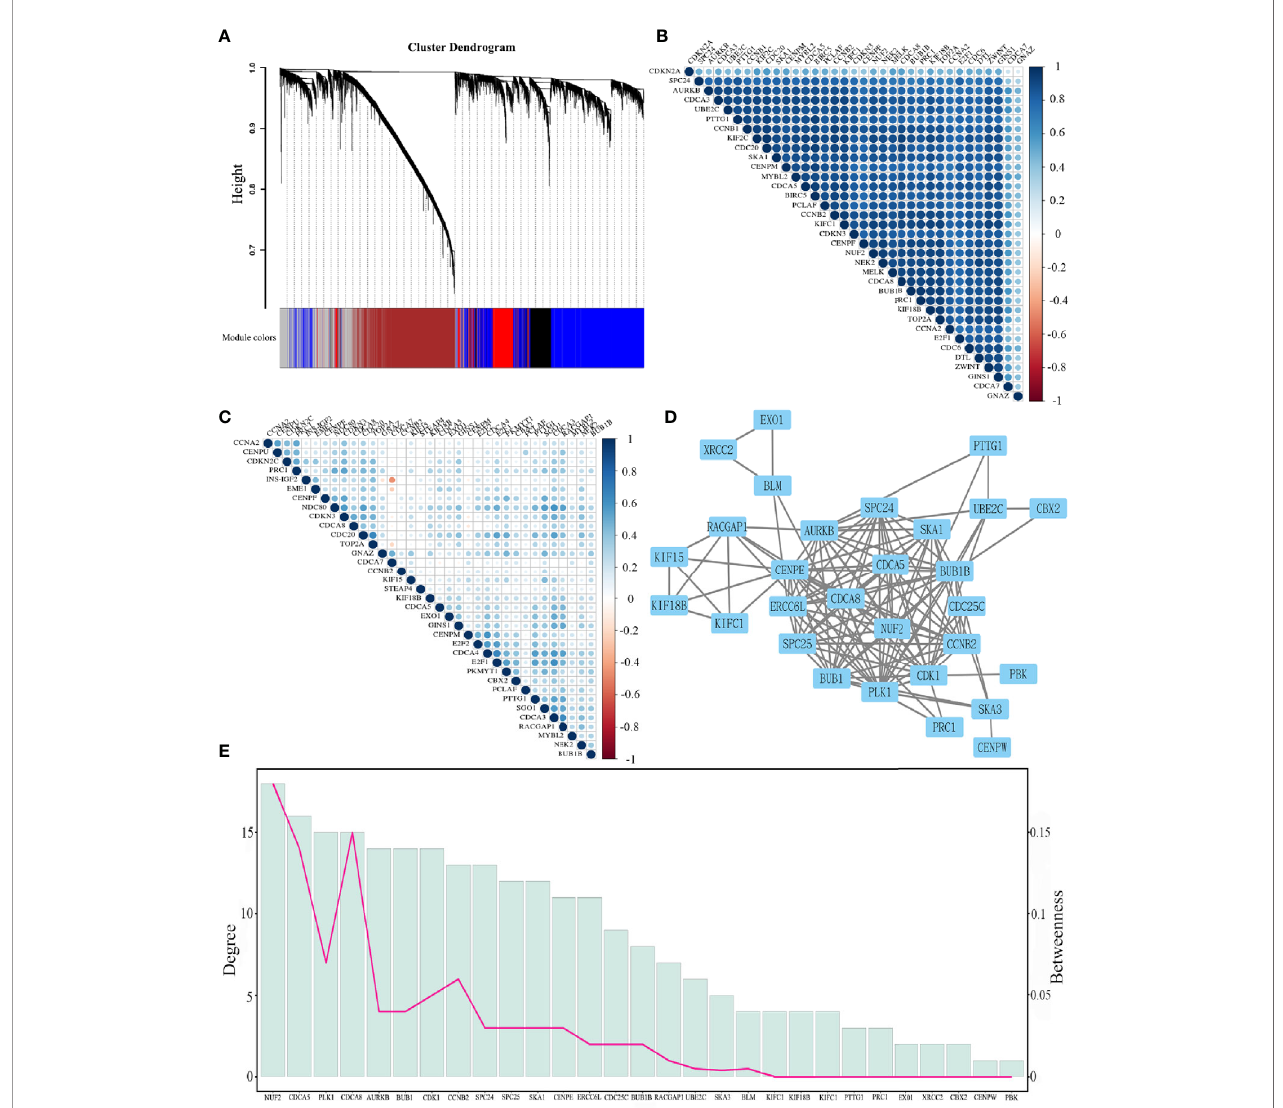
FIGURE 5 | (A) Cluster dendrogram of DNA methylation values into 11 modules. (B) Heatmap shows the correlation of the top 35 genes from co-expressed and co-methylated genes according to the standard deviation of the mRNA expression. (C) Heatmap shows the correlation of the top 35 genes from co-expressed and co-methylated genes according to the standard deviation of the DNA methylation values. (D) The protein-protein interaction network for co-expressed and co- methylated genes. (E) The degree and betweenness of 29 signi fi cant genes. The bar graph shows the degree, and the line graph indicates the